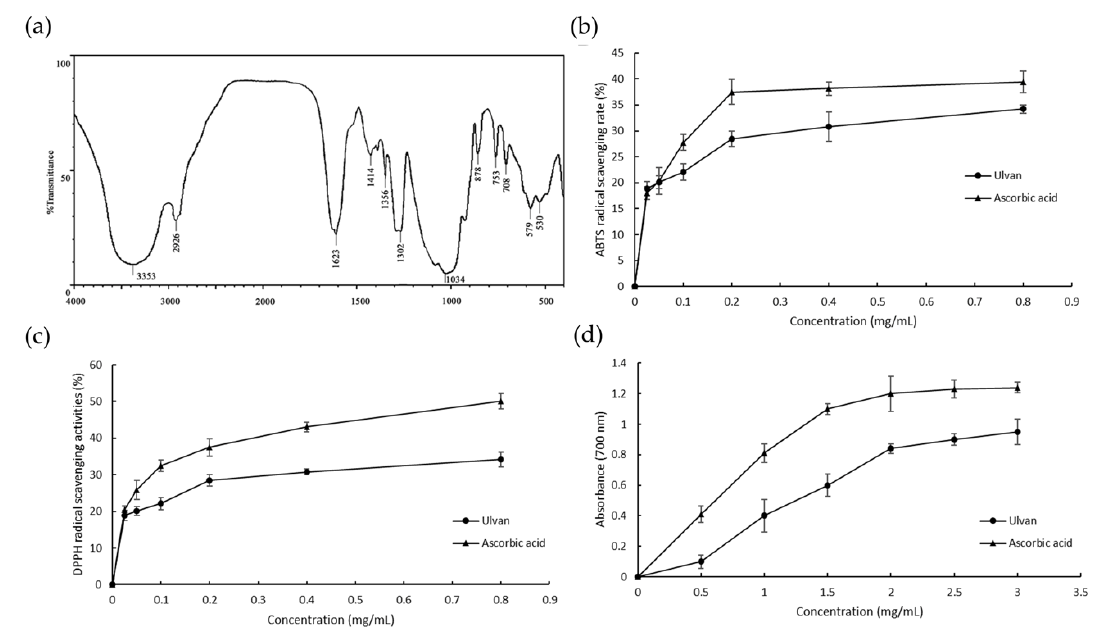
Figure 4. FT-IR spectra and antioxidant activity of the polysaccharide extracts from Ulva pertusa by the microwave-assisted extraction (MAE) method (mean ± SD, n = 3). ( a ) FT-IR spectra, ( b ) ABTS free radical scavenging assay, ( c ) DPPH free radical scavenging assay and ( d ) Reducing power assay. ABTS: 2,2’-azino-bis(3-ethylbenzothiazoline-6-sulphonic acid), DPPH: 1,1-diphenyl-2-picrylhydrazyl.